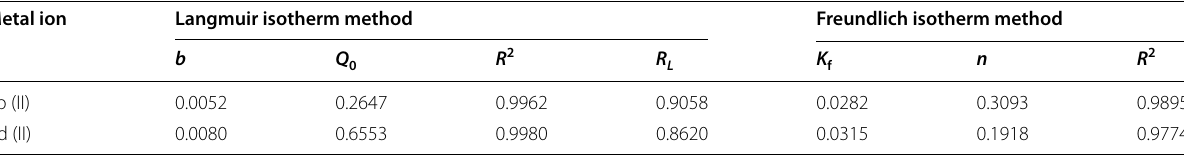
Table 3 Parameters of Langmuir and Freundlich isotherms for sorption of Pb(II) and Cd(II) on modified Amberlite XAD-4 resin Metal